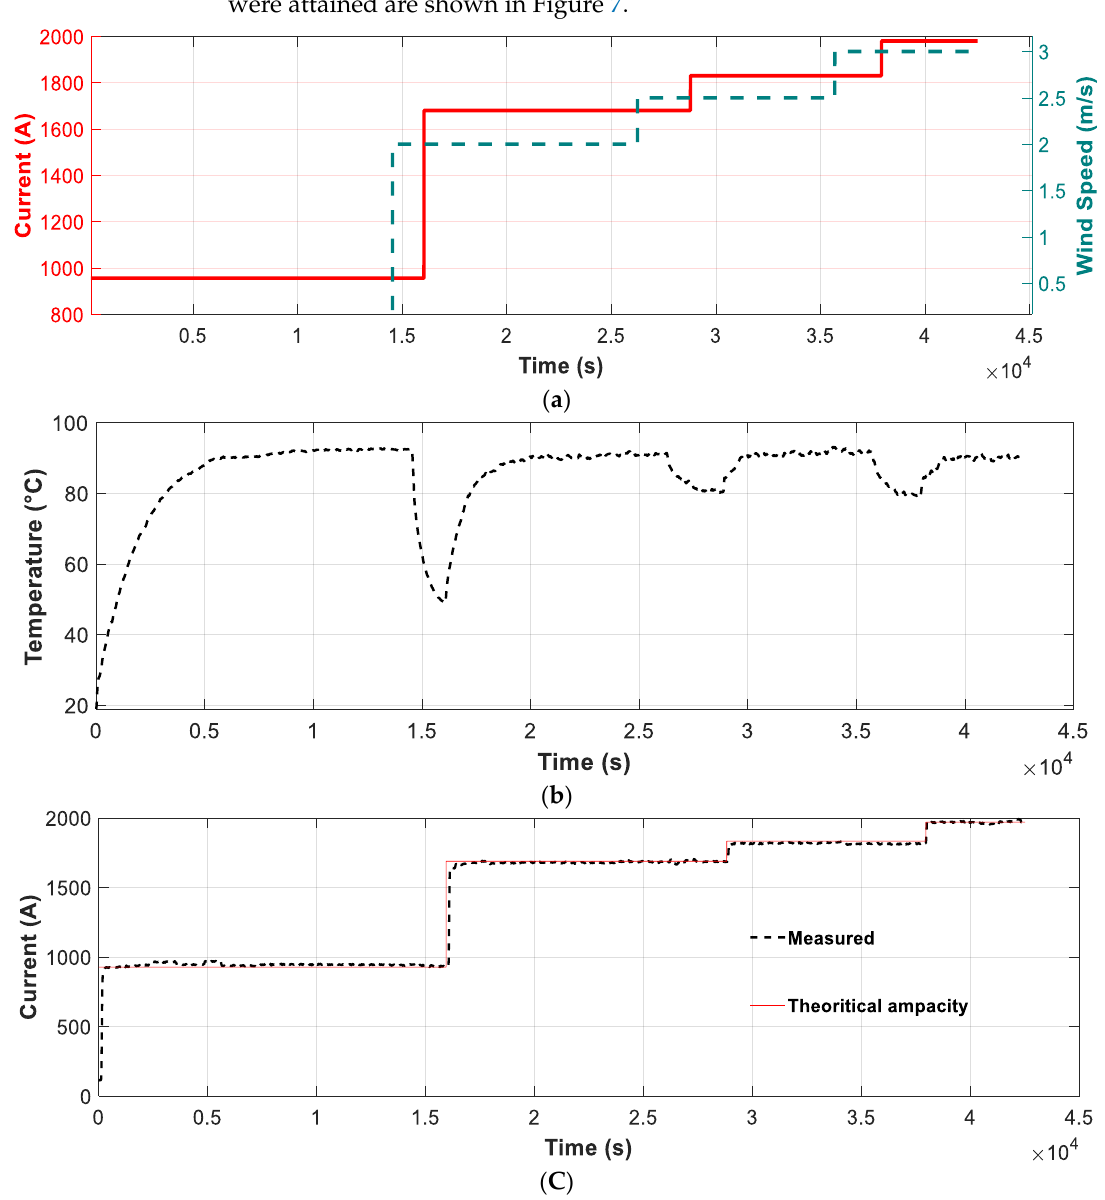
Figure 7. ( a ) Current and wind speed profiles during the test. ( b ) Conductor temperature measured by the T-type thermocouple and the Pt1000 sensor; ( c ) Applied and theoretical current values.